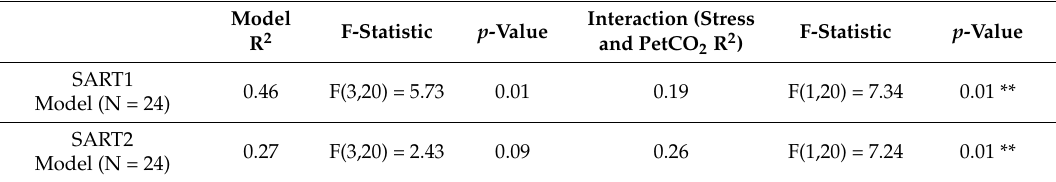
Table 4. Moderation models R 2 and interaction R 2 for SART1 and SART2.